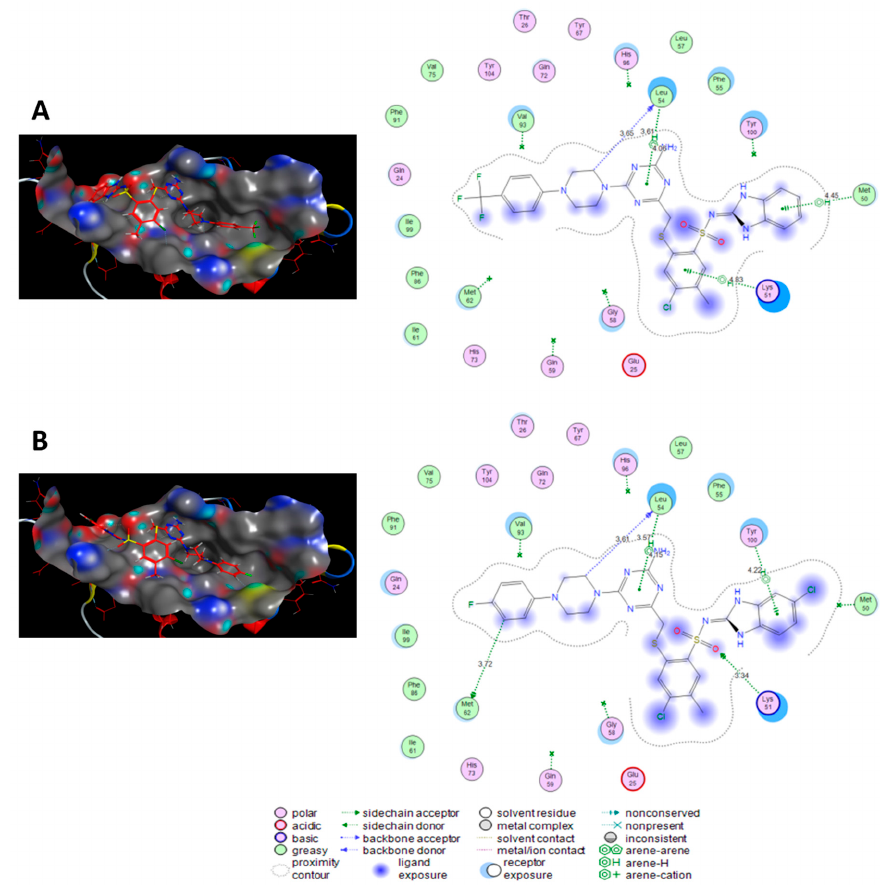
Figure 5. 3D and 2D representations of the protein–ligand interaction of compounds ( A ) 22 , and ( B ) 46 inside the active site of MDM2. Left side of figure: carbon and oxygen—red, nitrogen—blue, hydrogen—grey, sulfur—yellow, chlorine and fluorine—green.